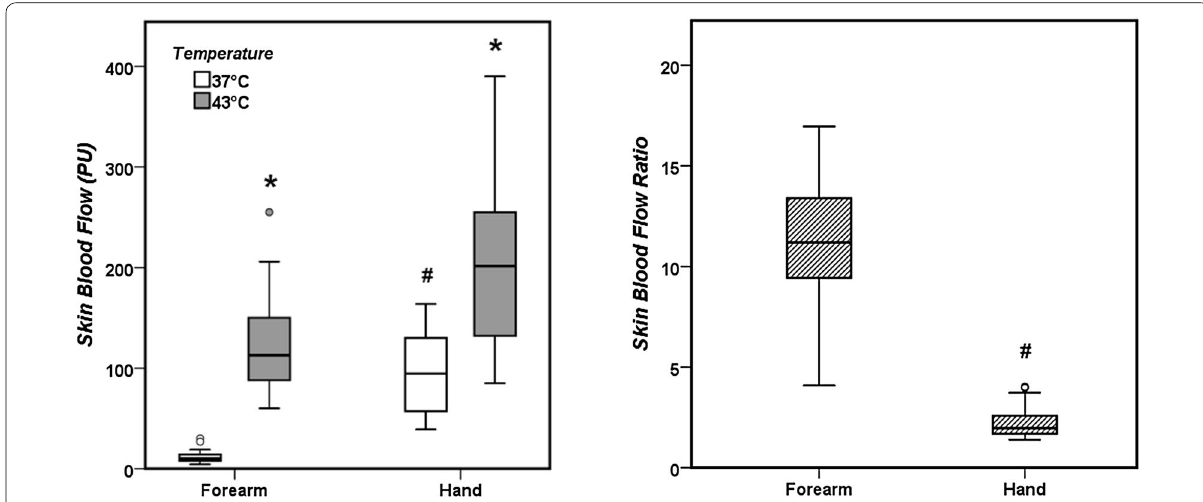
Fig. 1 Comparison of skin blood flow measurements at different temperatures on the forearm and the hand in healthy volunteers. In the right panel, the ratio of skin blood flow obtained between 43 and 37 °C is presented. * p < 0.05 compared with measurements at 37 °C; # p < 0.05 com‑ pared with forearm